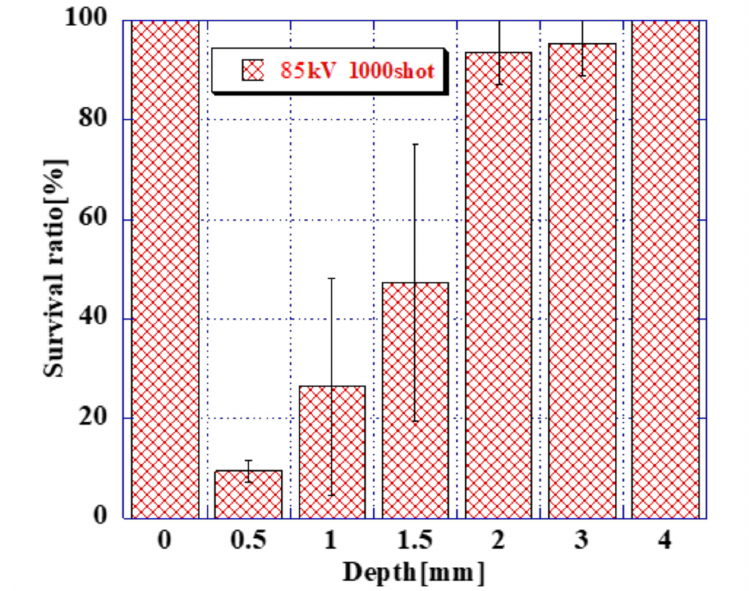
Figure 18. Survival ratios of E. coli for each depth of hollow in configuration (6).